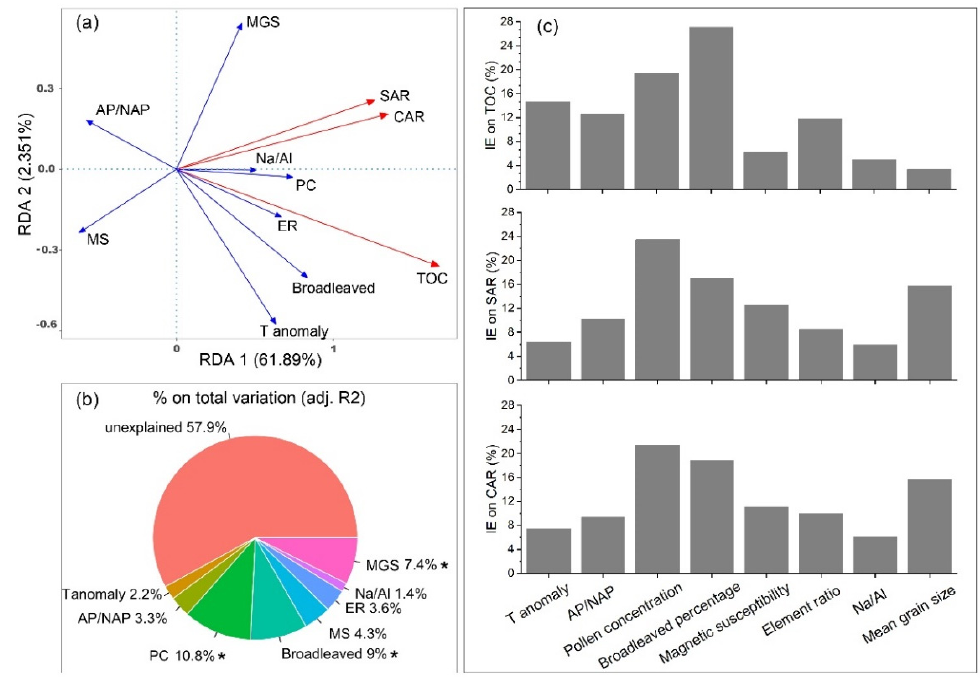
Figure 5. RDA ( a ) and HP ( c ) results for TOC, SAR, and CAR with the main drivers having signifi-